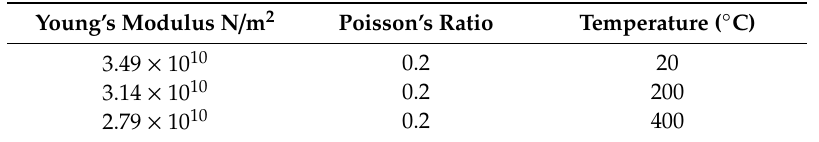
Table 4. Elastic properties for concrete (temperature dependent). (Class notes. Finite Element Analysis Lecture#5. Lawrence Tech. University, 2010 [24]).